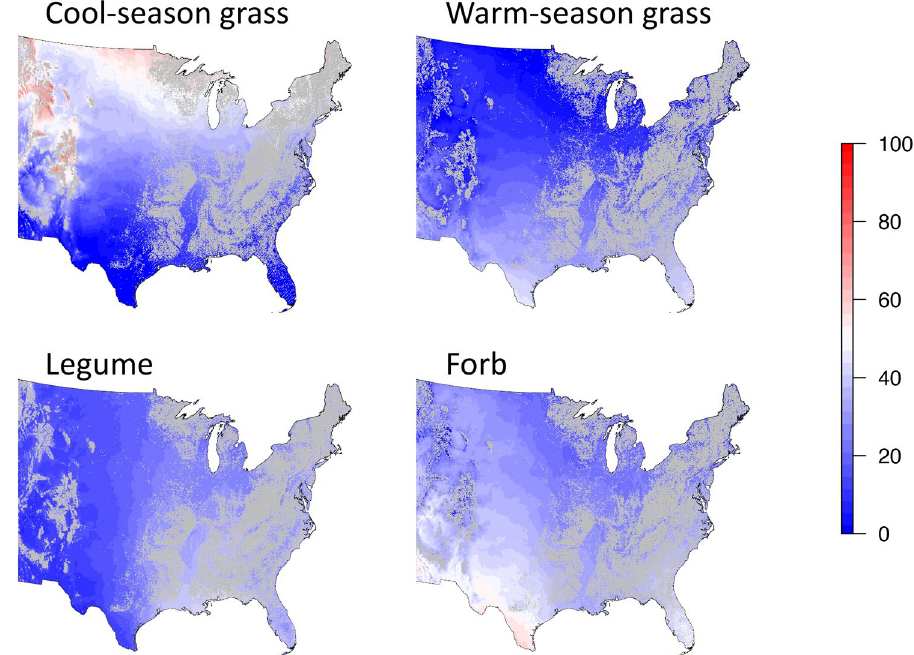
Figure 5. Maps of functional group composition of bison diet (excluding woody plants, which had low abundance and little pattern with climate) for non-forested areas. As there were no interactions between either MAT or MAP and the identity of the month, only maps for June are shown here. See Fig. 2 for how functional group composition of the diet changes over the six six months. Maps generated utilizing the raster package for reclassifying and masking pixels in R 3.5.2.